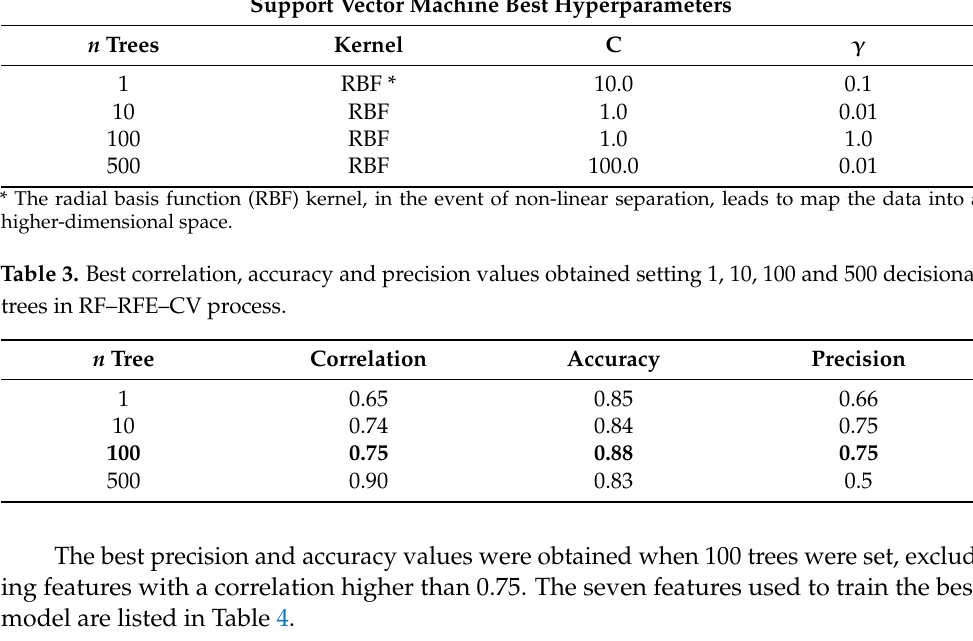
The best precision and accuracy values were obtained when 100 trees were set, exclud-